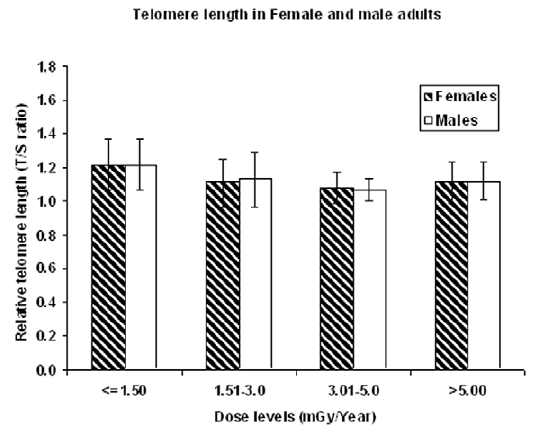
Figure 2. Telomere length among male and female adults with respect to various background dose levels. [( # 1.50 mGy/year: 34 males + 43 females, 1.51–3.0 mGy/year: 67 males + 80 females, 3.01– 5.0 mGy/year: 23 males + 27 females, . 5.00 mGy/year: 17 males + 19 females)].